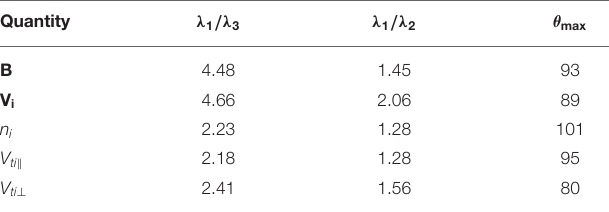
TABLE 2 | Results of the anisotropy and non-gyrotropy analysis for the different three dimensional spectra surveyed.